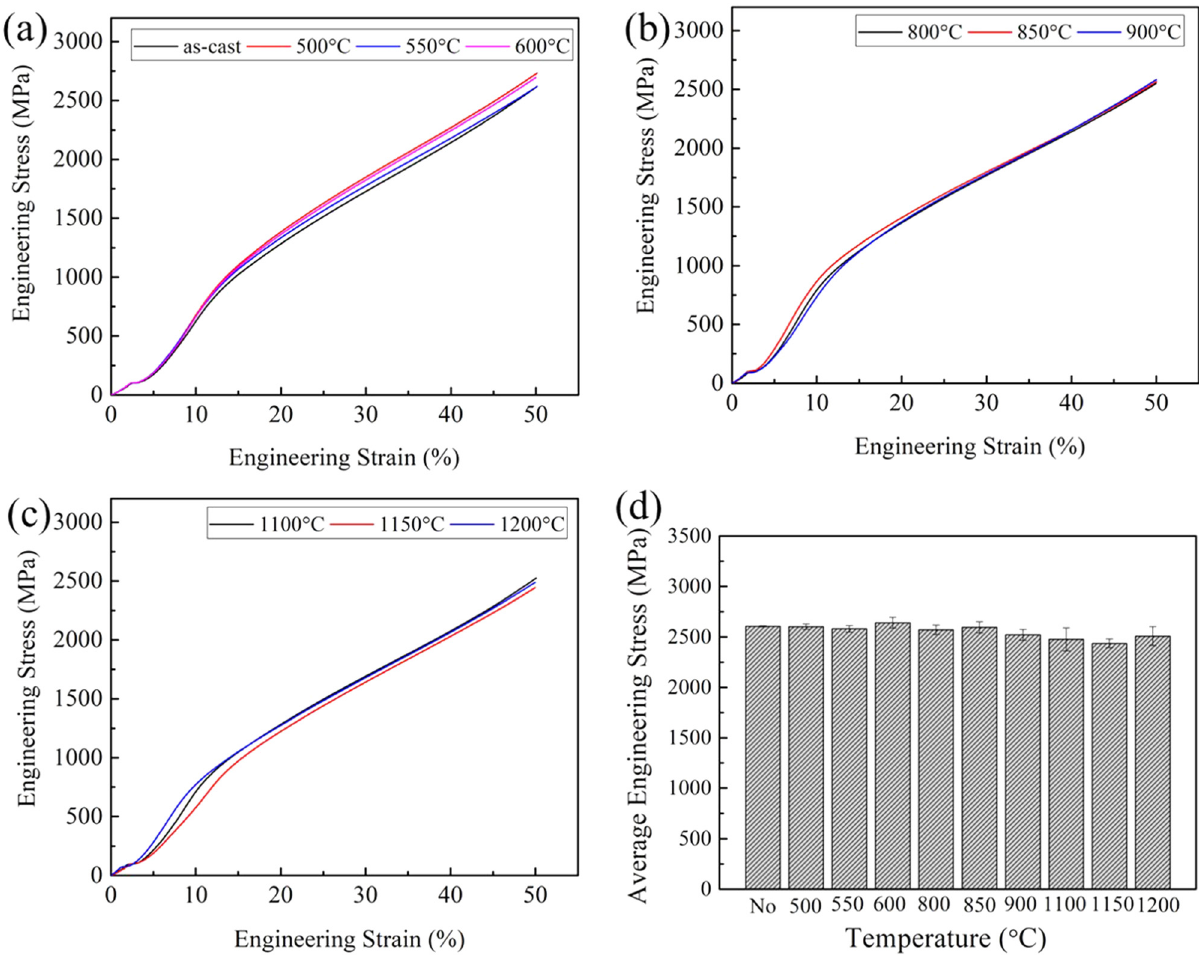
Figure 13: ( a ) Stress – strain curves of N - HT alloy, L - 50 alloy, L - 55 alloy, and L - 60alloy; ( b ) stress – strain curves of M - 80 alloy, M - 85 alloy, and M - 90 alloy; ( c ) stress – strain curves of H - 110 alloy, H - 115 alloy, and H - 120 alloy; and ( d ) average compressive strength of as - sintered and as - annealed Co 28.5 Cr 21.5 Fe 20 Ni 26 Mo 4